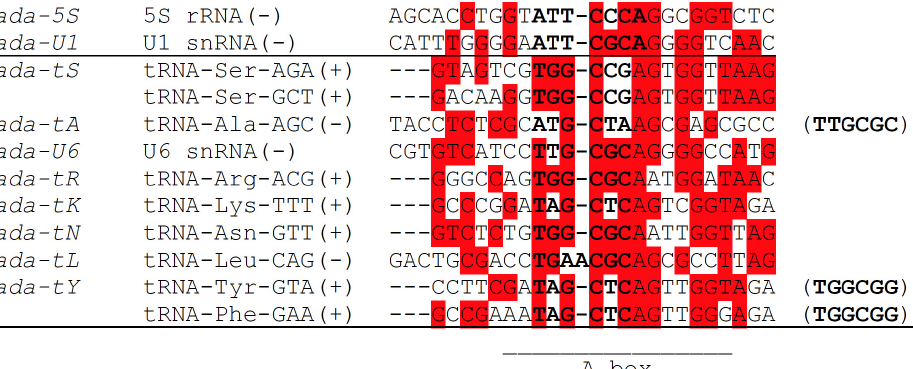
Figure 3. Sequence comparison of targets of Dada . From left, Dada family names, target RNA genes with directions (+, direct; − complementary), the nucleotide sequences around the insertion sites; if the TSDs are often replaced by another sequence, it is shown at the right in parentheses. The nucleotides corresponding to TSDs are in bold. The most frequent nucleotide is highlighted in red at each site. The A box of RNA polymerase III promoter found in tRNA genes is indicated.